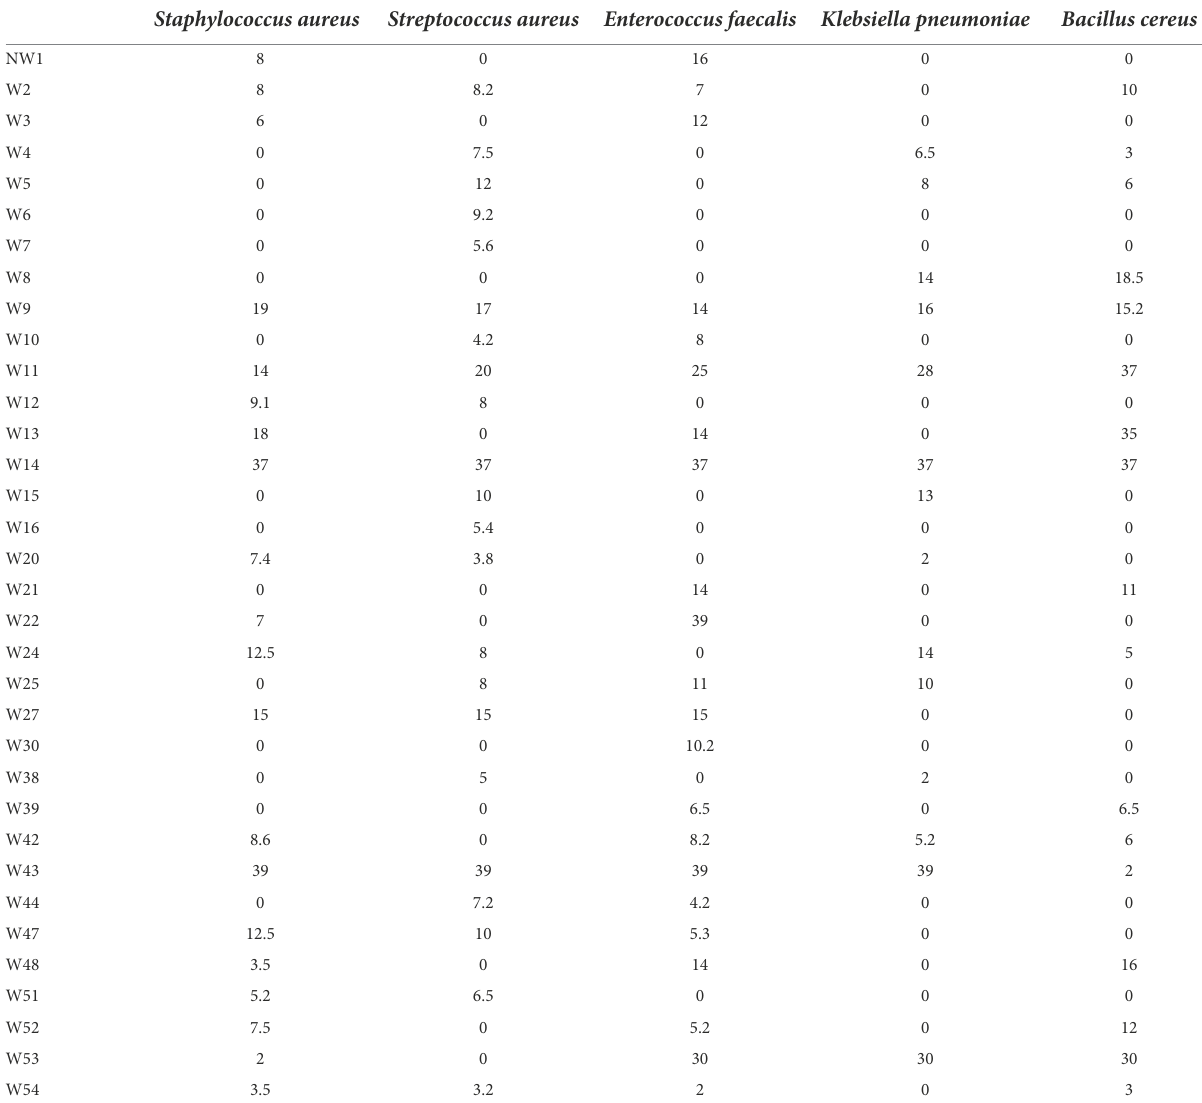
TABLE 1 Screening of cave isolates using cross streak method against five pathogenic bacteria. Cave